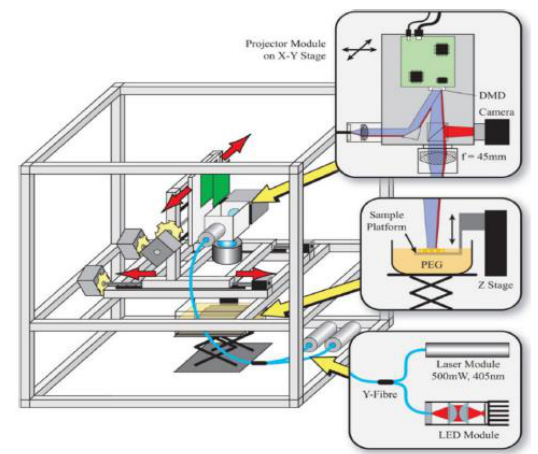
Figure 3. A stereolithography 3D printer (reprinted with permission from Lee et al.; copyright (2015) [81]). The translational stages and projector system are supported by an aluminum frame